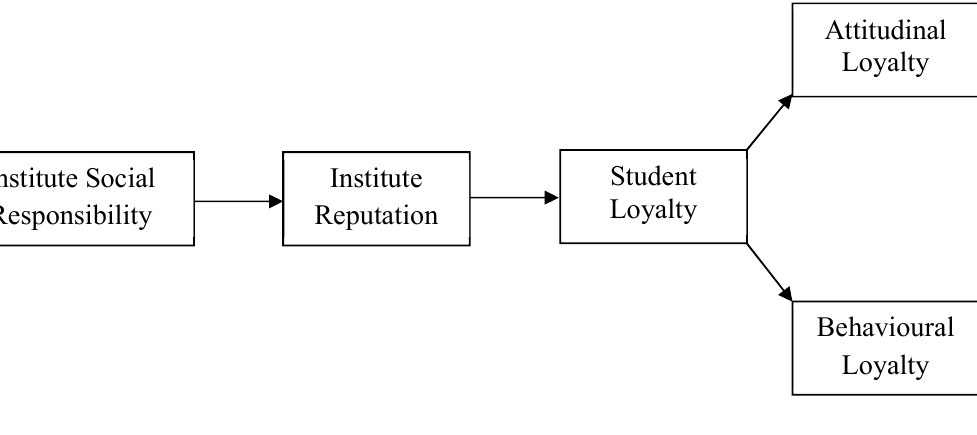
Fig. 1. Theoretical